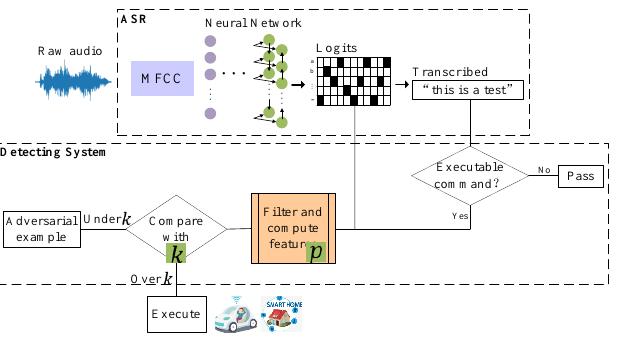
Figure 4. Deployment of the detection system.